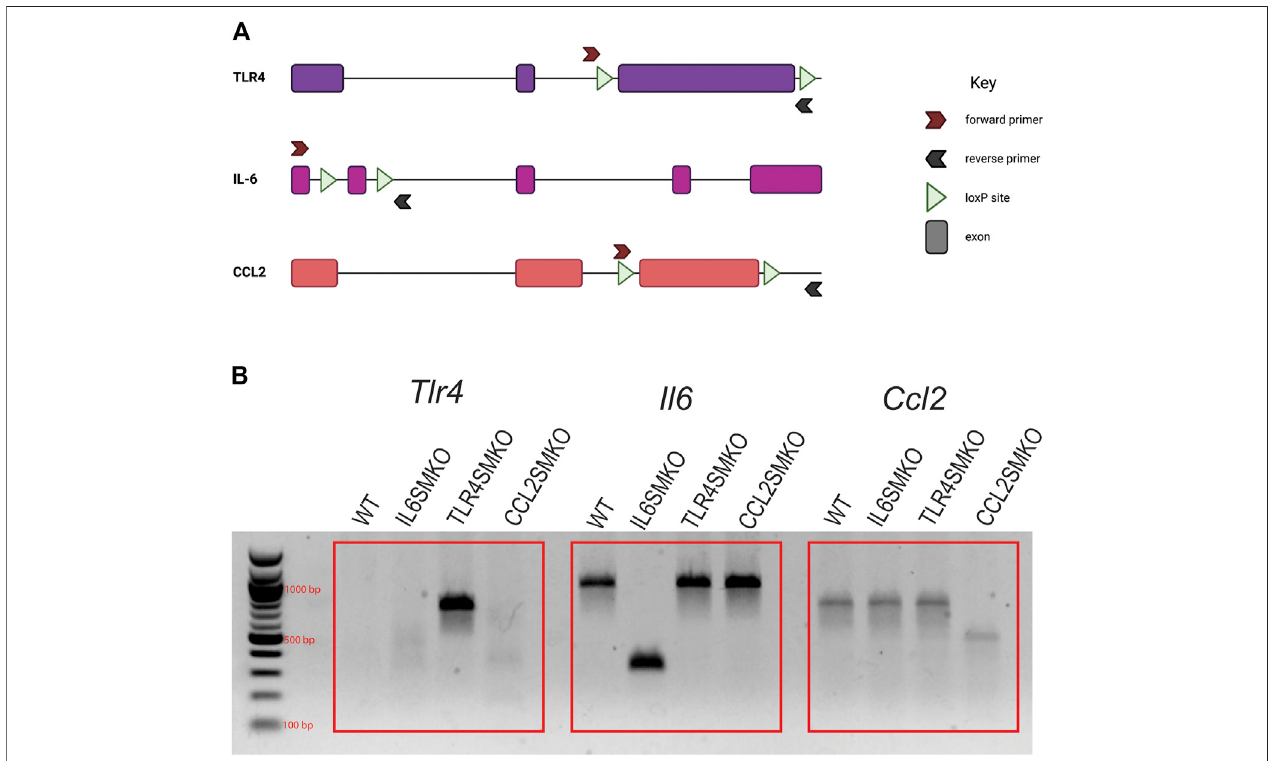
FIGURE 1 | Con fi rmation of DNA recombination in skeletal muscle of targeted mice. Human skeletal actin MerCreMer mice were crossed with mice containing either fl oxed Tlr4 , Il6 , or Ccl2 and given intraperitoneal injections of tamoxifen (75 mg/kg) for 5 consecutive days. (A) Simpli fi ed schematic of TLR4, IL-6, and CCL2 genomic constructs and PCR primer annealing sites. (B) PCR products from gastrocnemius muscle to con fi rm Cre-mediated gene recombination. Due to the size of exon 3 of TLR4, PCR ampli fi cation only occurs in recombined tissues. Data are representative of all mice tested ( n = 11 – 39/group). Figure 1A was created using